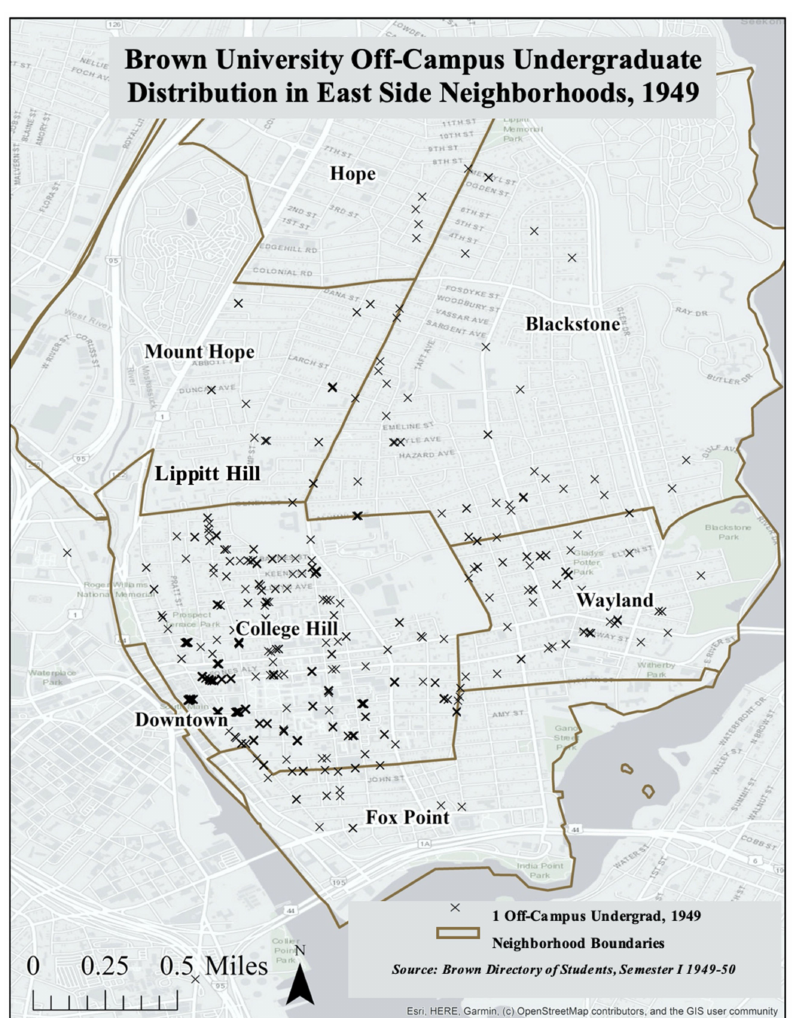
Figure 3. Brown University o ff -campus undergraduate distribution in East Side neighborhoods,